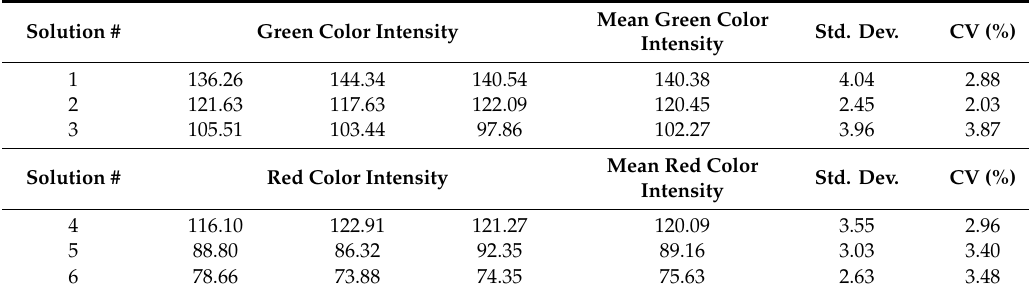
Table 3. Intra-assay coe ffi cients of variation (CV).